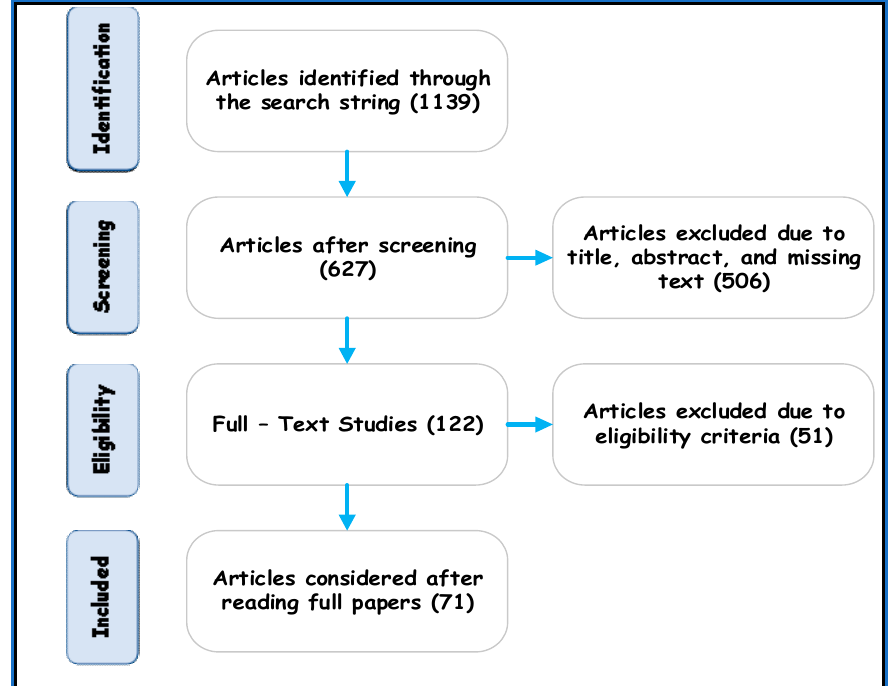
Figure 5. Article selection procedure [68,69].